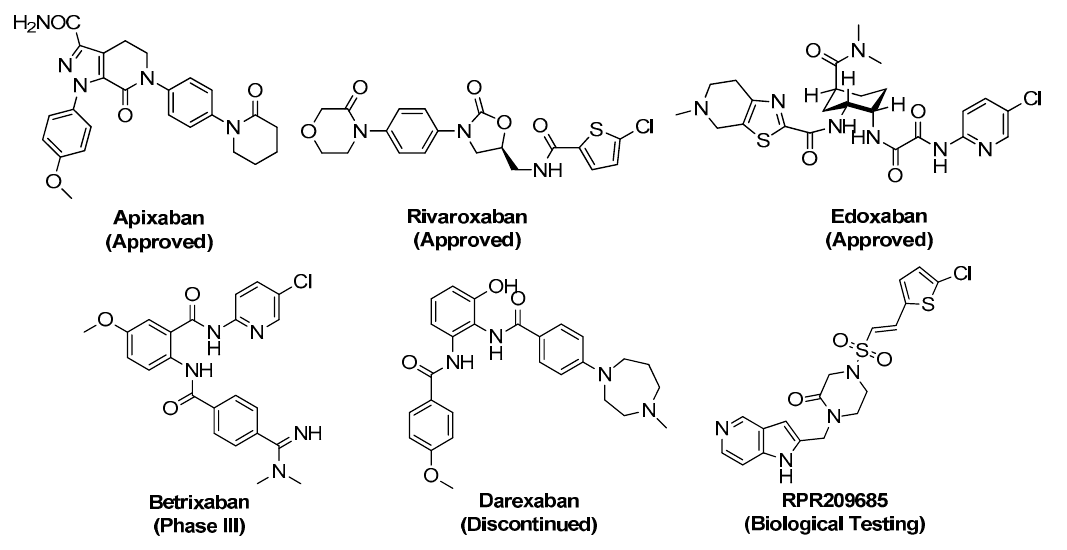
Figure 1. Oral direct FXa inhibitors.